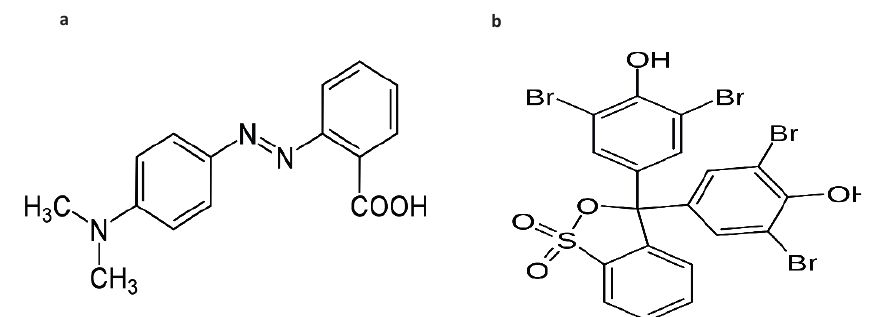
Figure 5: Chemical structures of target dyes a) methyl red and b) bromophenol